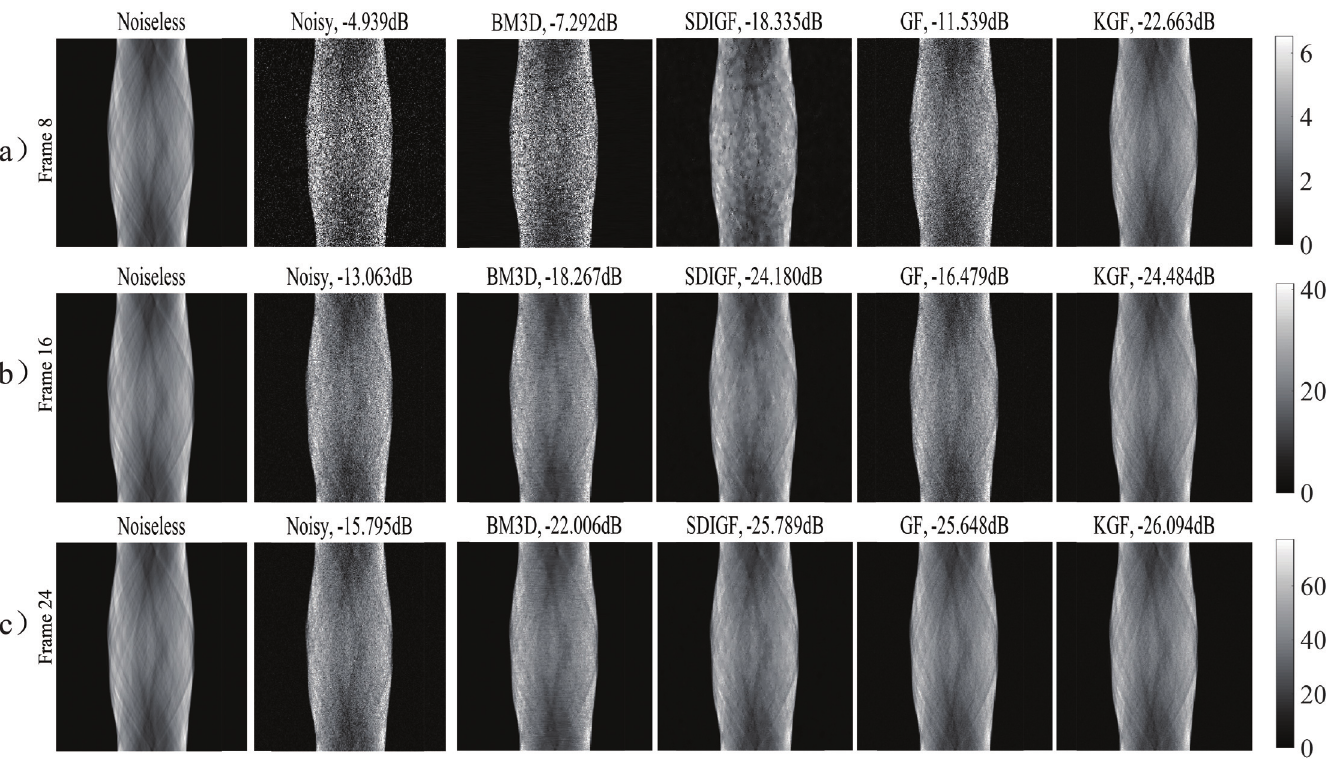
Fig 2. Sinograms denoised by different methods: (a) Frame 8 (count = 68k), (b) Frame 16 (count = 492k), (c) Frame 24 (count = 914k). Noiseless column: noiseless sinograms; Noisy column: noisy sinograms; other columns: sinograms denoised by respective methods. The dB values are MSEs of noisy or denoised sinograms.